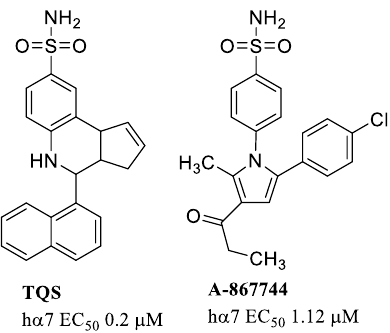
Figure 9. Examples of type II α 7-PAMs with arylsulfonamide ring.